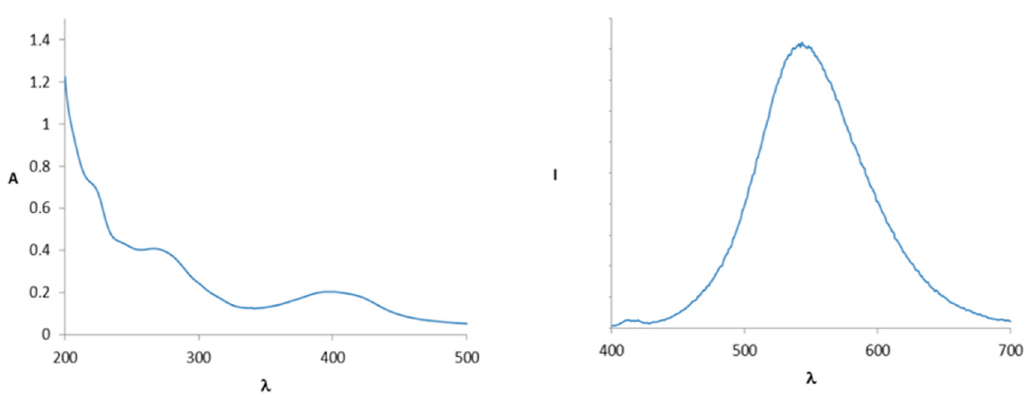
Figure 2. UV spectrum ( left ) and fluorescence spectrum ( right ) (excitation at 366 nm) of compound 1 ( c = 1.72 × 10 − 5 M).